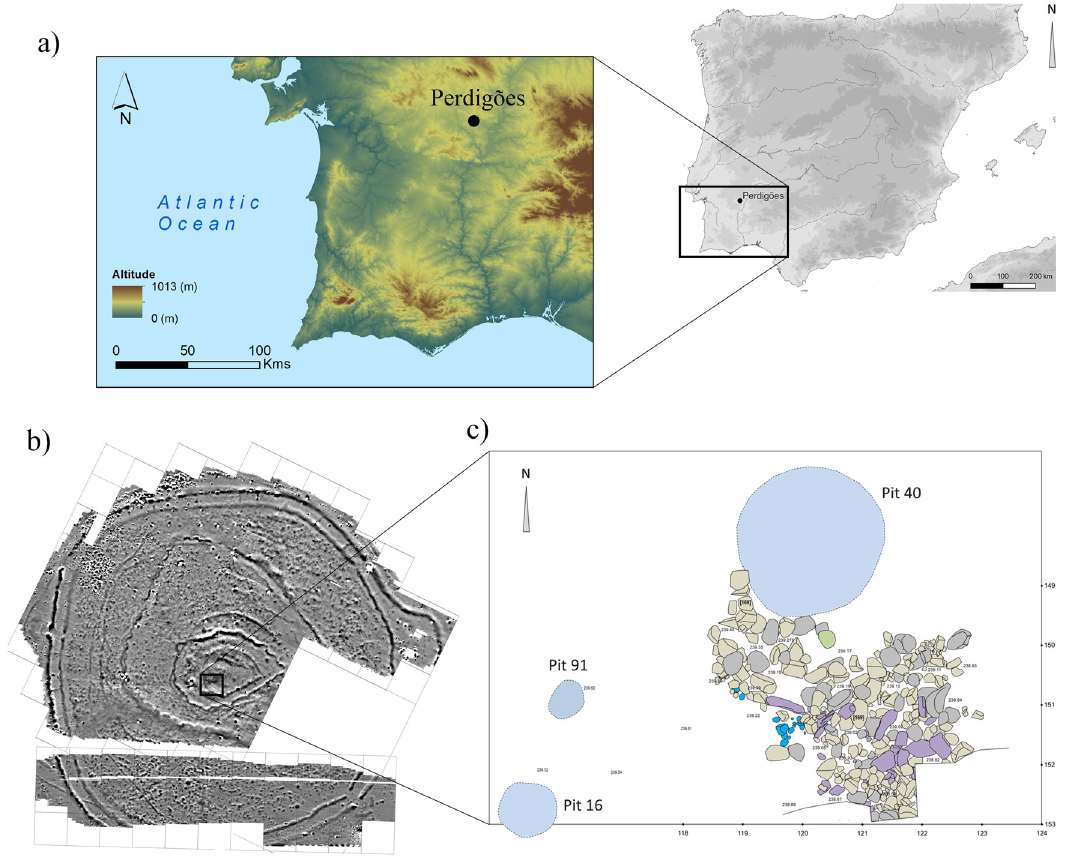
Figure 1: Location of Perdigões in the Iberian Peninsula and in the Alentejo region ( a ) ; magnetogram of the archaeological site with location of pits 16 and 40 ( b ) ; features with cremated remains in the central area of Perdigões ( c ) ( after Valera, 2020 )